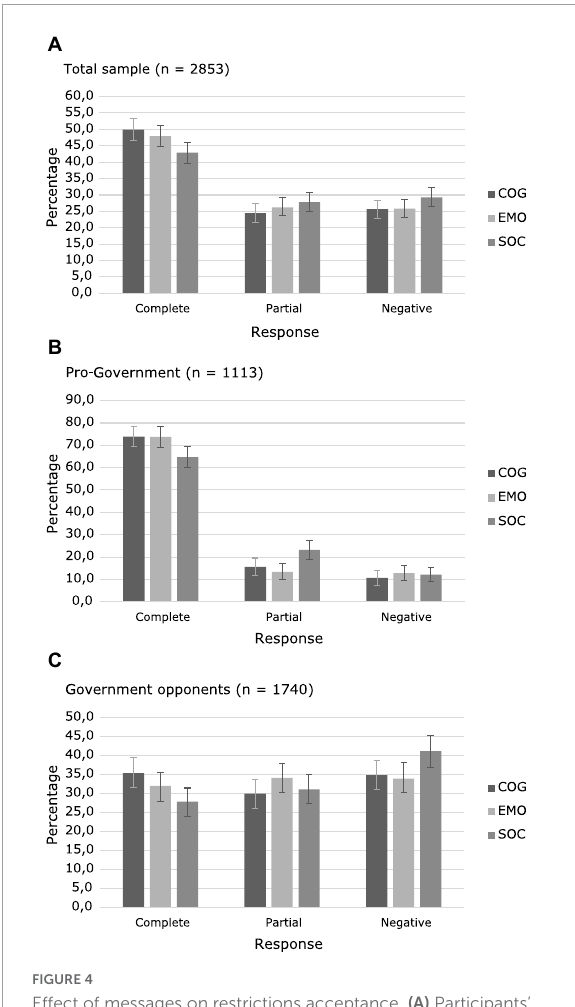
FIGURE4 Effect of messages on restrictions acceptance. (A) Participants’ responses to the three types of messages in the total sample. (B) Participants’ responses to the three types of messages among the government supporters. (C) Participants’ responses to the three types of messages among the opposition supporters. Error bars represent bootstrapped 95% CI (COG, cognitive risk message; EMO, emotional risk message; SOC, pro-social message; Complete response: “Support all necessary restrictions”; Partial response: “Support some additional restrictions”; Negative response: “Support only the current restrictions” or “No restrictions at